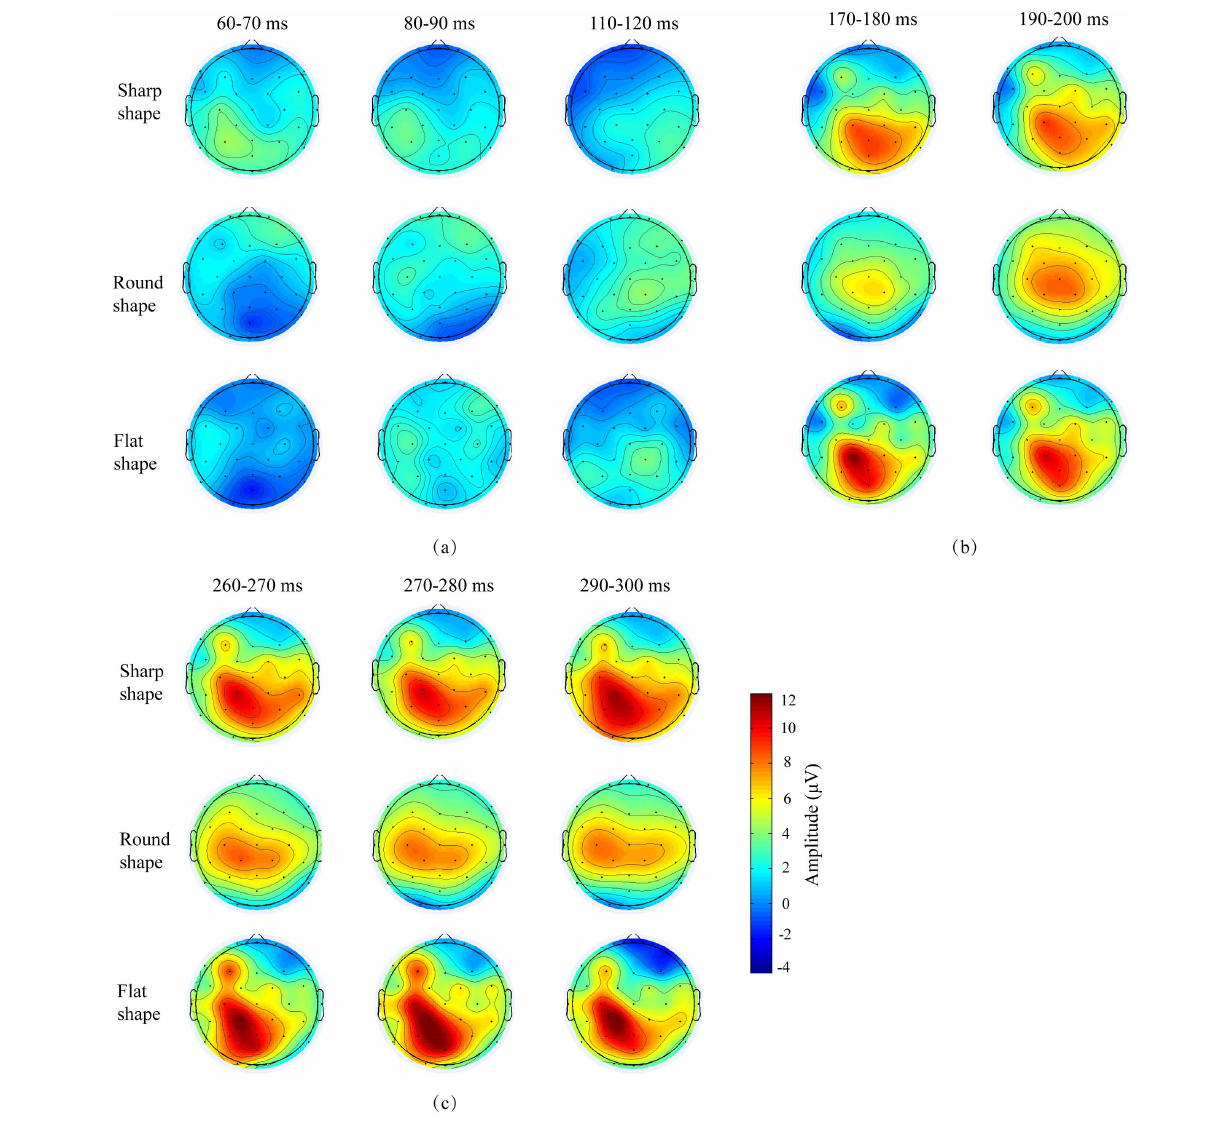
FIGURE 4 | Average ERP scalp maps of three shapes of texture samples from 0 to 600